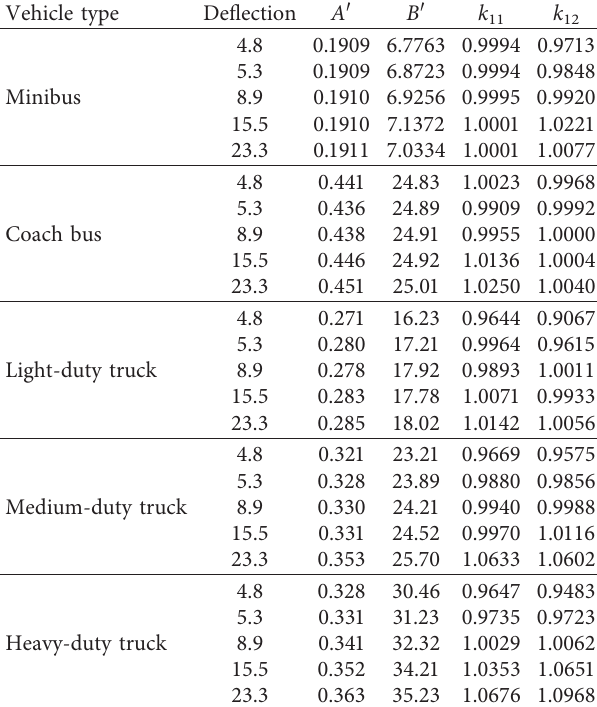
Table 6: Correction parameters based on the